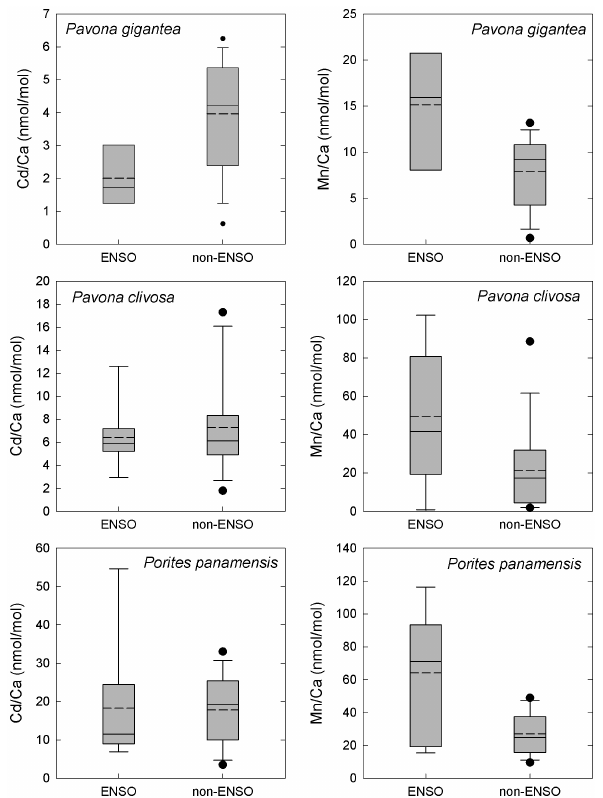
Fig. 6. Box plot separating the Cd/Ca and Mn/Ca ratios between ENSO and Non-ENSO years. The solid line and dashed lines inside the box shows the median and the mean of the distribution, respec- tively.